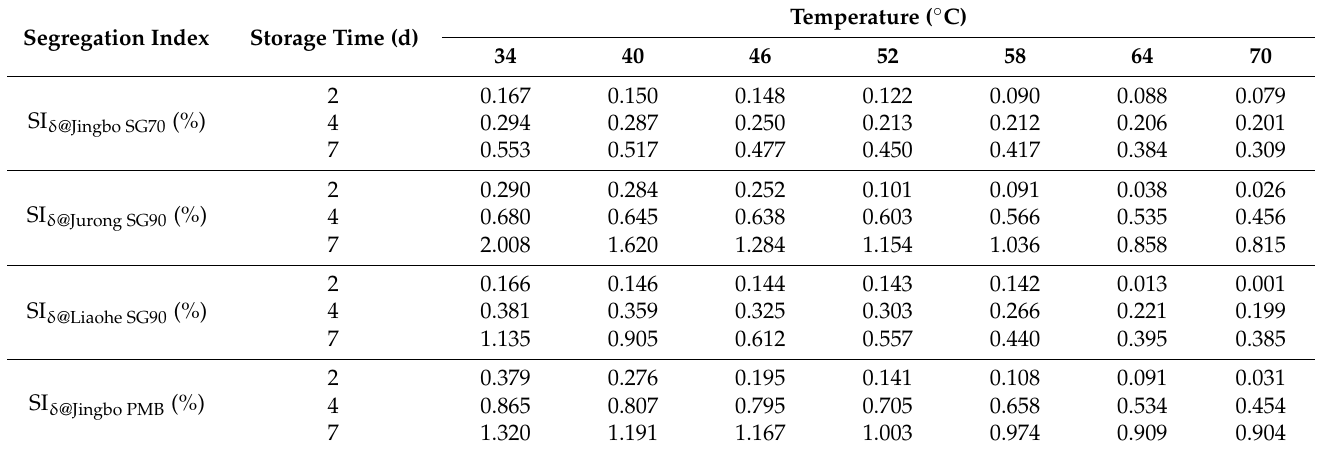
Table 5. Phase-angle segregation indexes of various bitumen binders at different storage